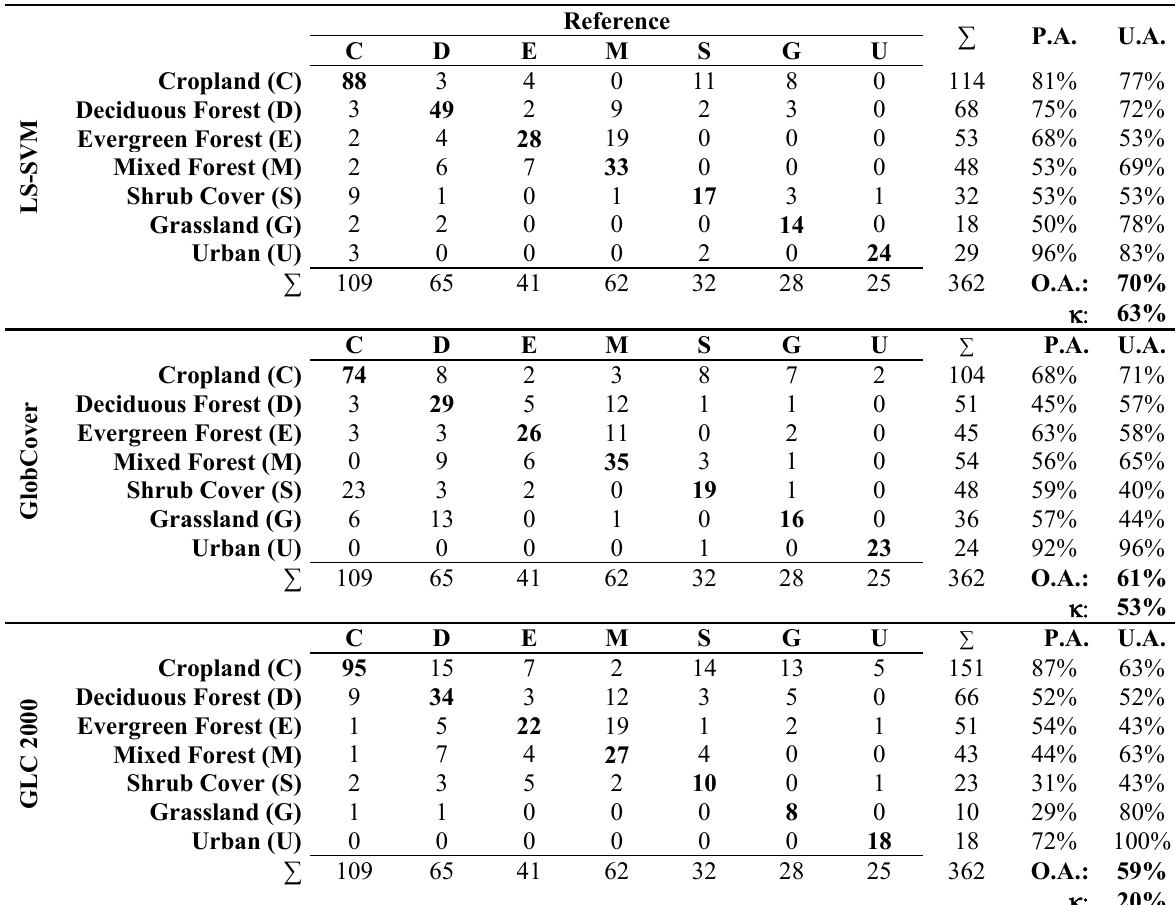
Table 3. Error matrices and statistical measures for LS-SVM, GlobCover and GLC2000. Validation dataset excluding points of low spatial homogeneity (n matrix was summarized based on the statistical measures: Producer’s Accuracy (PA), User’s Accuracy (UA), Overall Accuracy (OA) and the Cohen’s Kappa coefficient ( κ ). The visual interpretation of GE imagery was considered the ground truth (Reference).